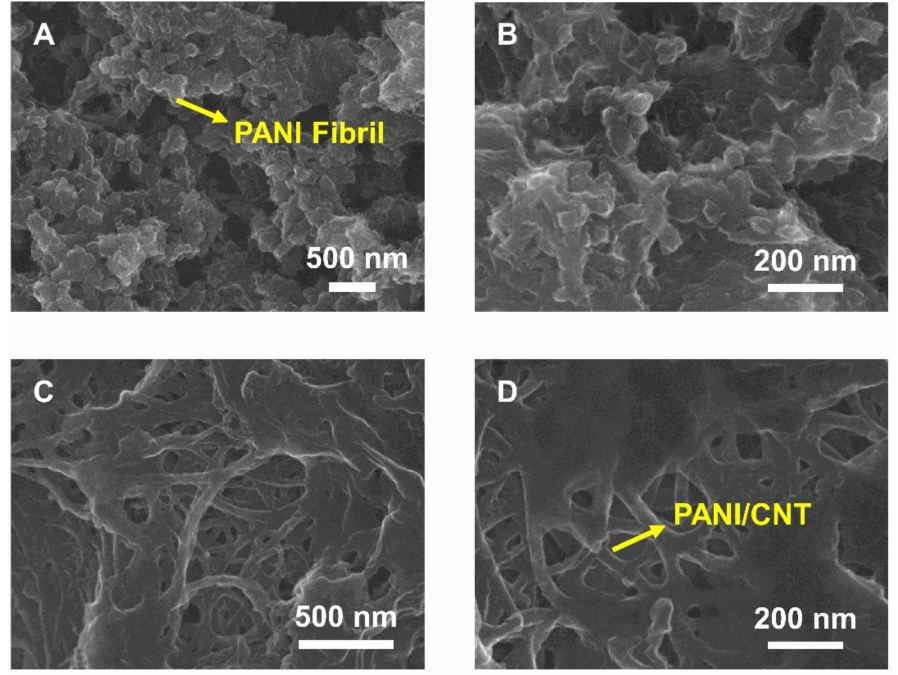
Figure 2. Scanning electron microscope (SEM) images of ( A ) PANI and ( B ) an enlarged image of PANI. ( C ) The PANI/CNT nanocomposite and ( D ) an enlarged image of the PANI/CNT nanocomposite. FT-IR spectra were obtained to determine the chemical constitutions of the PANI/CNT nanocomposite. As shown in Figure 3, PANI had distinct peaks at 1550cm − 1 , 1483 cm − 1